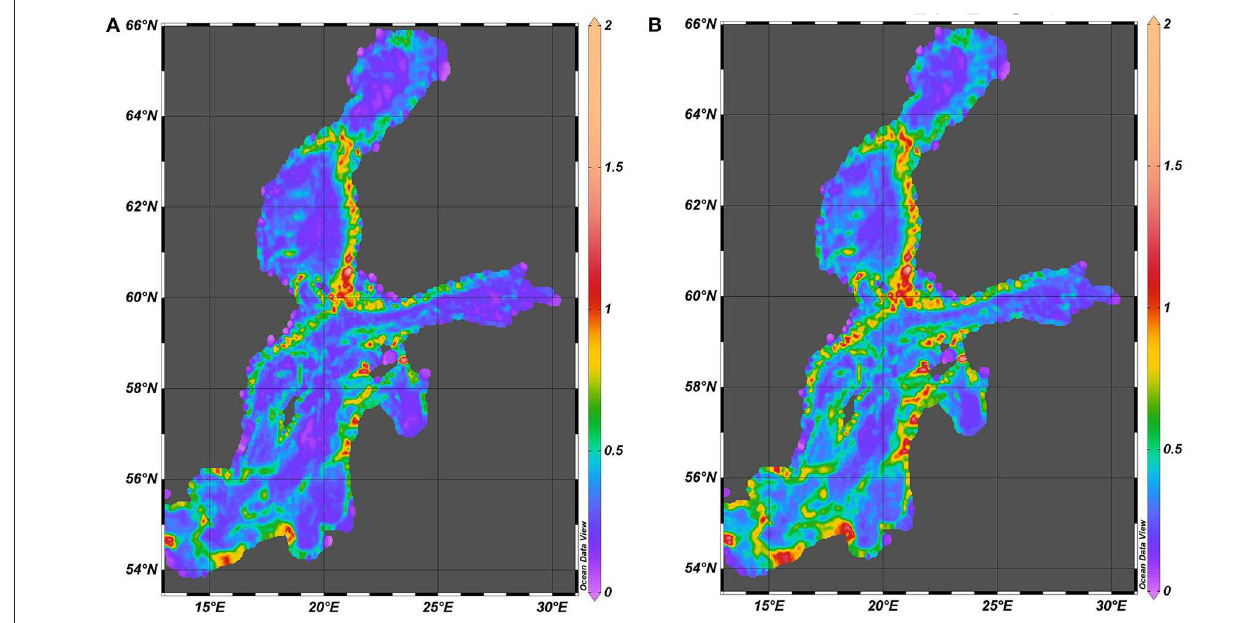
FIGURE 10 | Spatial distribution of the spectral amplitude of nearbed speed (cm/s) in 1961–1965 (A) and in 2000–2005 (B)